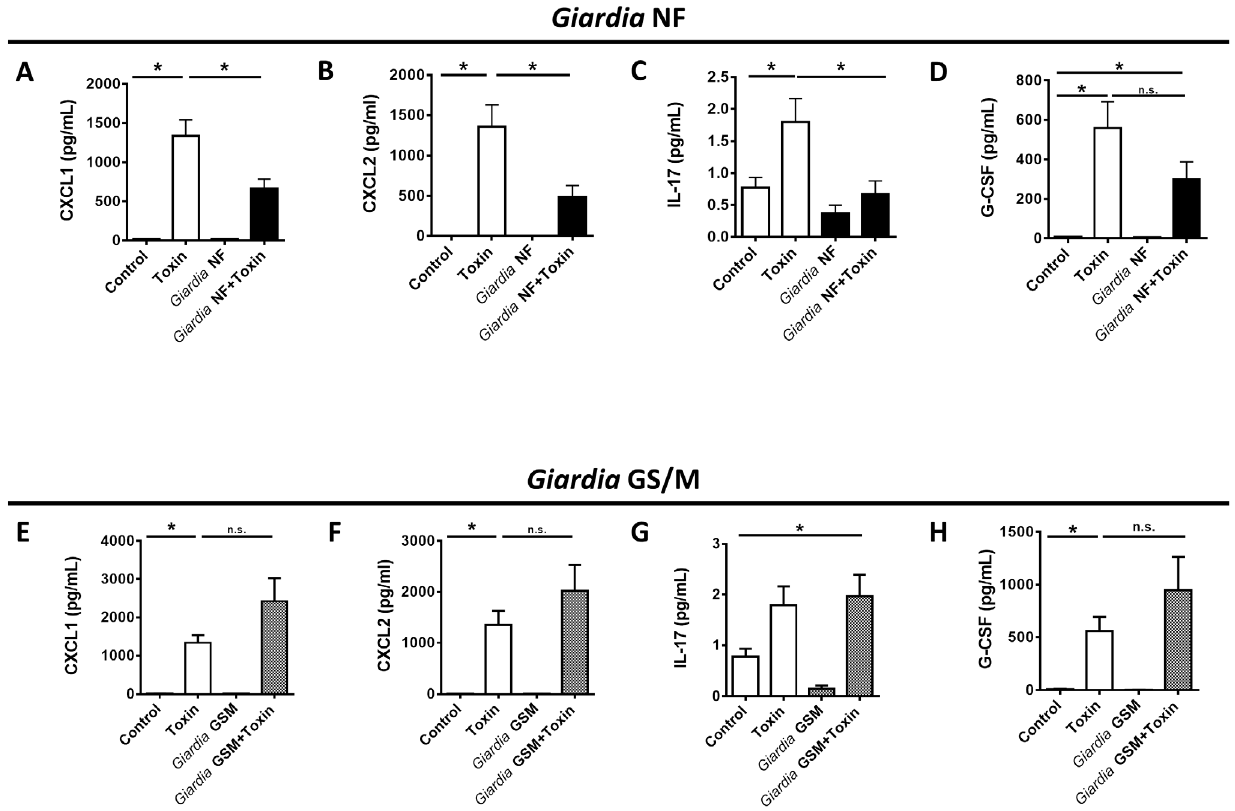
Figure 3. Giardia NF infections attenuate colonic expression levels of several PMN-associated mediators following administration of C.difficile TcdAB. Male C57BL/6 mice, aged 4 to 6 weeks, were infected with Giardia NF or GS/M trophozoites. 7 days post-infection, animals were given 100 m g of TcdAB or PBS i.r. and, after 3 hours, animals were euthanized. Levels of (A) CXCL1, (B) CXCL2, (C) IL-17, and (D) G-CSF were compared between Giardia NF-infected animals and uninfected animals given i.r. 100 m g of TcdAB or PBS. Levels of (E) CXCL1, (F) CXCL2, (G) IL-17, and (H) G-CSF were compared between Giardia GS/M-infected animals and uninfected animals given i.r. 100 m g of TcdAB or PBS. Values were determined via bead- based cytokine assay. All data are representative of two independent experiments (n=5–11/group) and represented as mean 6 SEM. n.s.=not significant * p , 0.05.